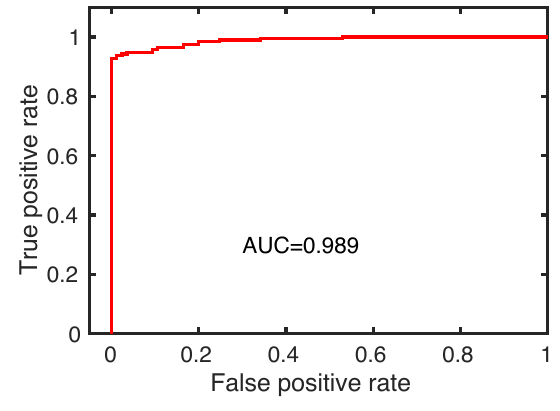
Figure 5. ROC curve of proposed classifier.